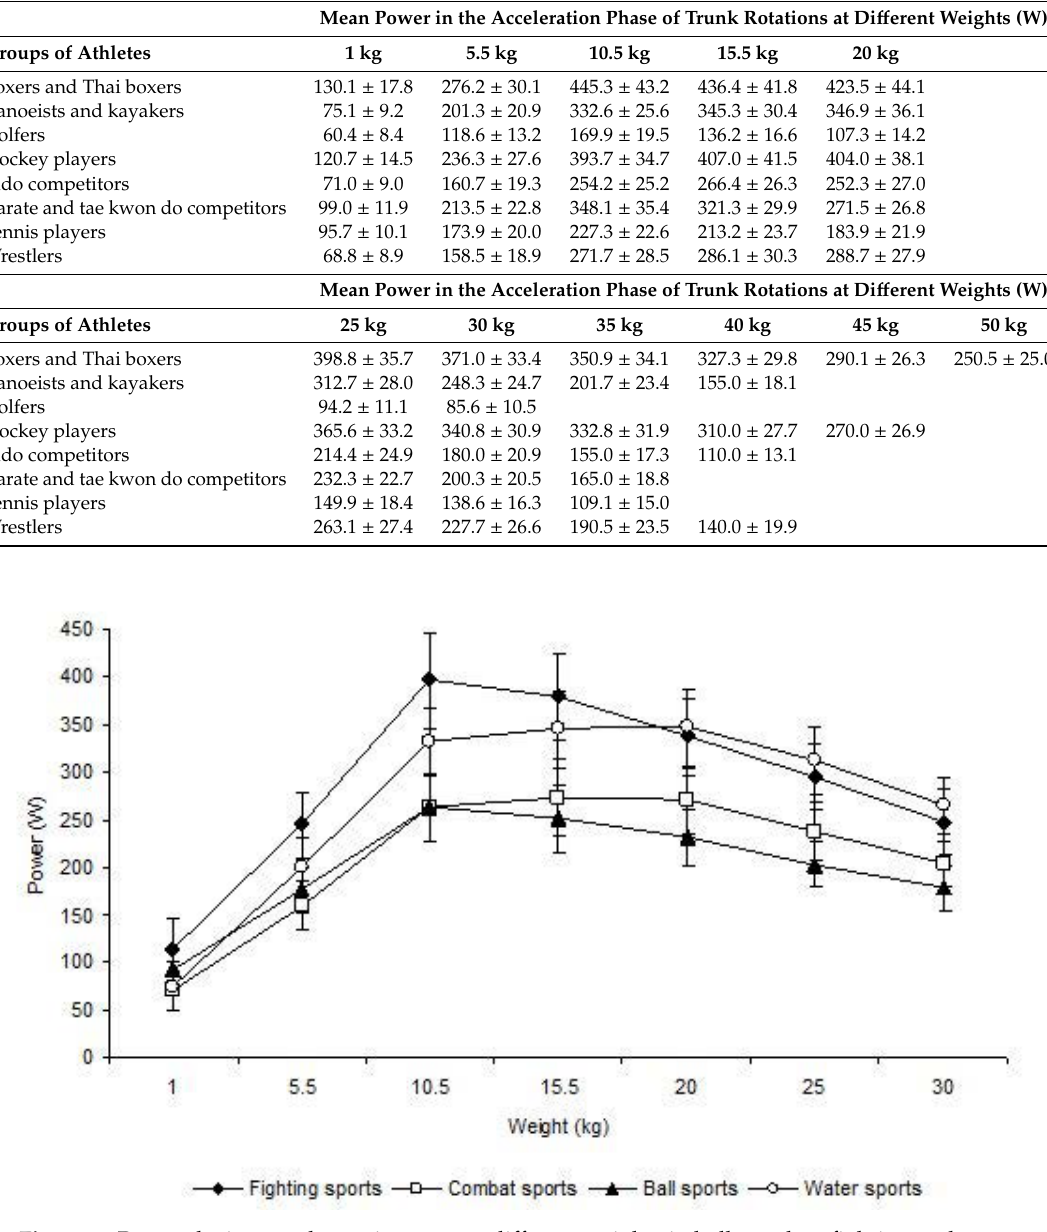
Figure 1. Power during trunk rotations across di ff erent weights in ball, combat, fighting and water sports athletes.